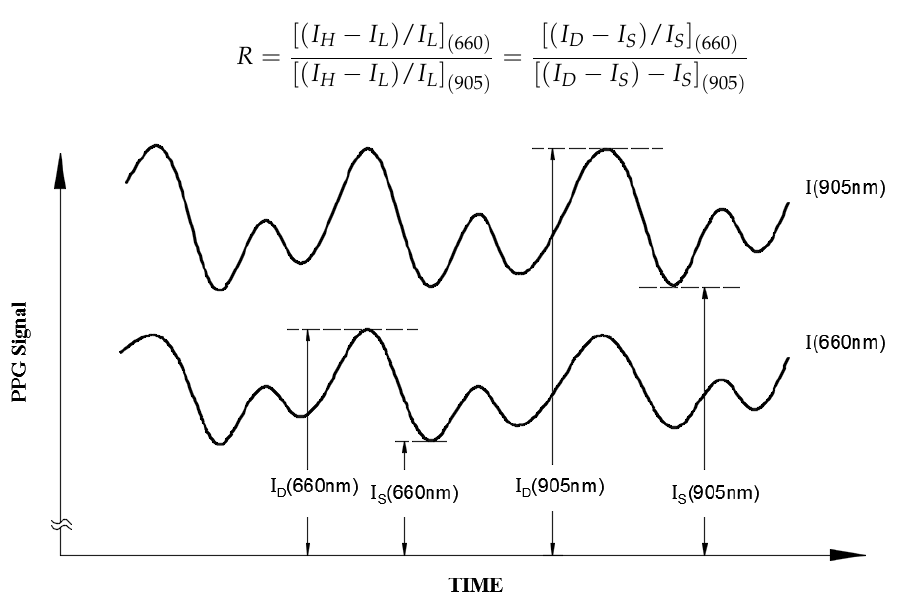
Figure 3. Illustration of the separated red (660 nm) and infrared (905 nm) patient signals with their I D and I S values caused by arterial pulsation.